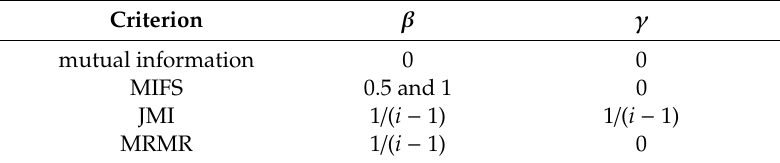
Table 3. Tested parameter values for β and γ in di ff erent